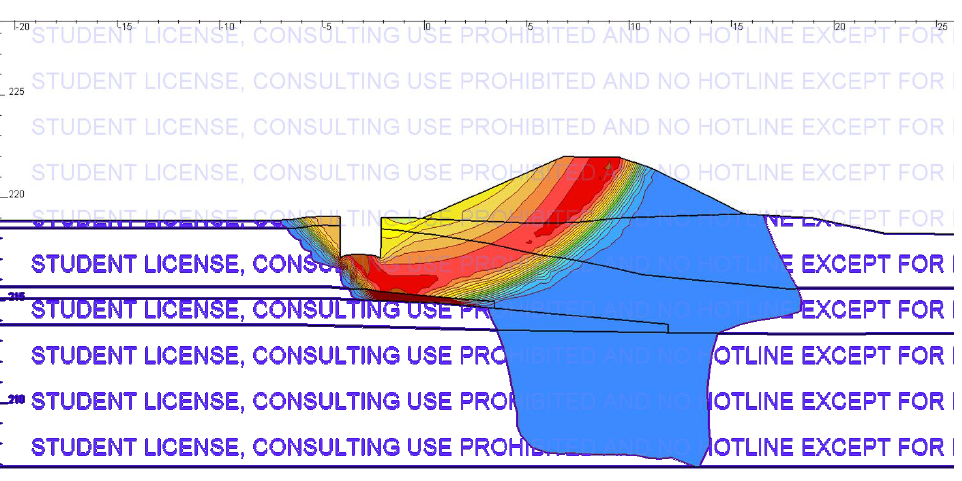
Figure 9: Failure mechanism of the embankment with shallow excavation with “system excavation support,” the same in all phases of the flood.